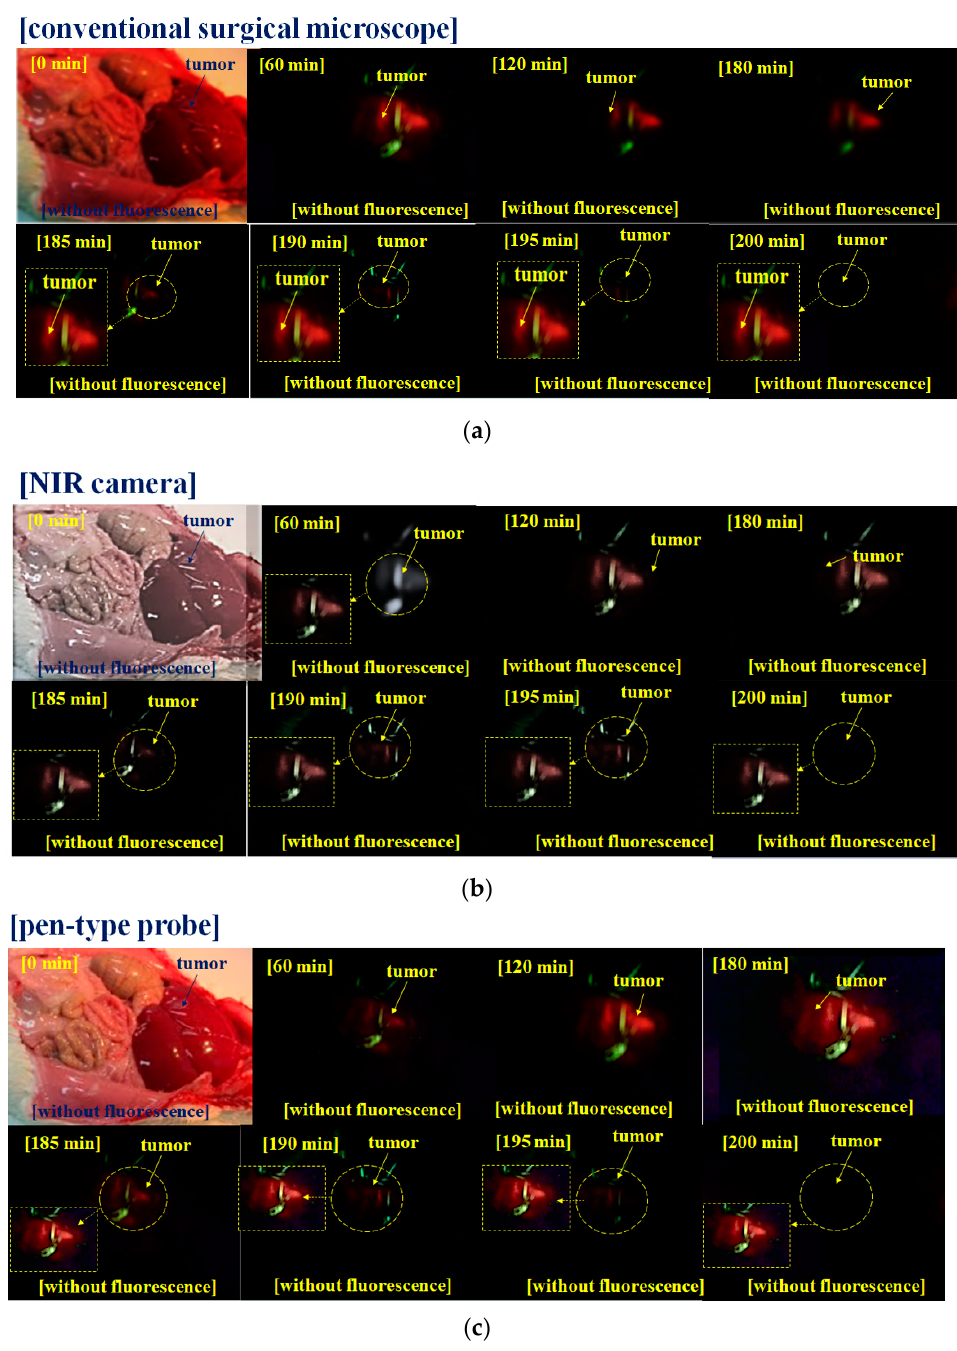
Figure 8. Experimental results of small animals ( a ) conventional surgical microscope (output power (excitation wavelength) and WD of 160 mW/cm 2 (405 nm) and 15 cm) ( b ) NIR camera of Lt-225c (output power (excitation wavelength) and WD of 60 mW/cm 2 (405 nm) and 15 cm) ( c ) pen-type probe camera (output power (excitation wavelength) and WD of 4.0 mW/cm 2 (405 nm) and 50 mm).